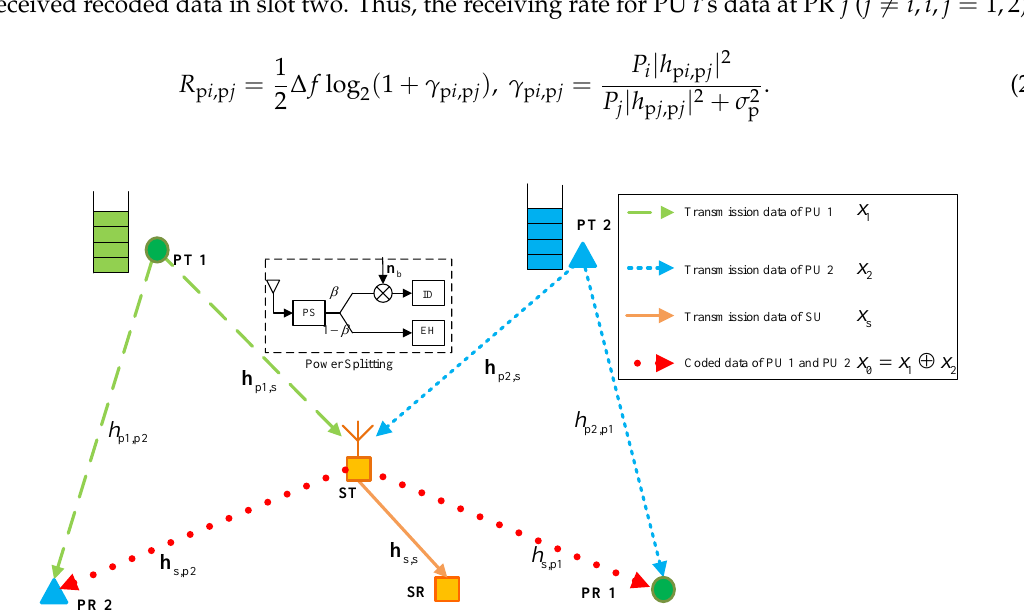
Figure 2. System model of two-to-one network coding (NC)-assisted energy and spectrum cooperation in cognitive cooperation